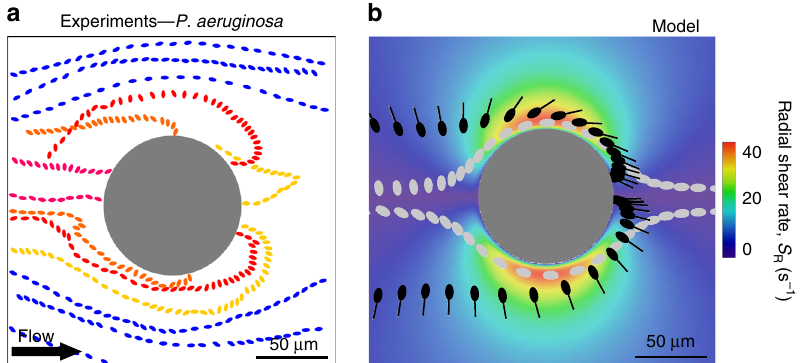
Fig. 4 Fluid shear affects the trajectories of swimming bacteria around a pillar. a Sample trajectories and orientation of P. aeruginosa PA14 wt cells in fl ow around a 100- µ m pillar at U/V = 3.3 ( U = 150 µ m s − 1 ), for motile (warm colors) and nonmotile (blue) cells. b Trajectories of motile (black) and nonmotile (gray) cells, simulated without rotational noise ξ R , in fl ow around a 100- µ m pillar at U/V = 3.3 simulated with the model. The color scale represents the radial shear rate, S R , around a 100- µ m pillar at U = 500 µ m s − 1 , reported in Fig. attachment sites around the pillar: motile cells preferentially pillar, measured in terms of the fl uorescence intensity of motile, attach on the leeward surface of the pillar (orange curve, GFP-tagged PA14 wt cells (Fig. 1d; Supplementary Methods). The Supplementary Fig. 4), whereas nonmotile cells attach only on preferential leeward attachment is clearly visible in terms of a its windward side (yellow curve, Supplementary Fig. 4). Further- higher fl uorescence intensity, for example for the case of a fl ow more, in experiments in which the fl ow direction was reversed velocity U/V = 6.6 (Fig. 2a). Preferential leeward attachment was after 2.5 h, a second, symmetric attachment peak formed on the observed only for motile cells, and was not observed for the two opposite side (the originally windward side) of the pillar over the nonmotile PA14 strains ( fl gE and motB; Fig. 2b, c). The latter ensuing 2.5 h, independently of the growth medium (Supple- preferentially attach on the windward side of the pillar, as mentary Fig. 5), further con fi rming the robustness of the expected for passive particles 35 . The mathematical model shows that bacterial motility determines the distribution of bacterial phenomenon.